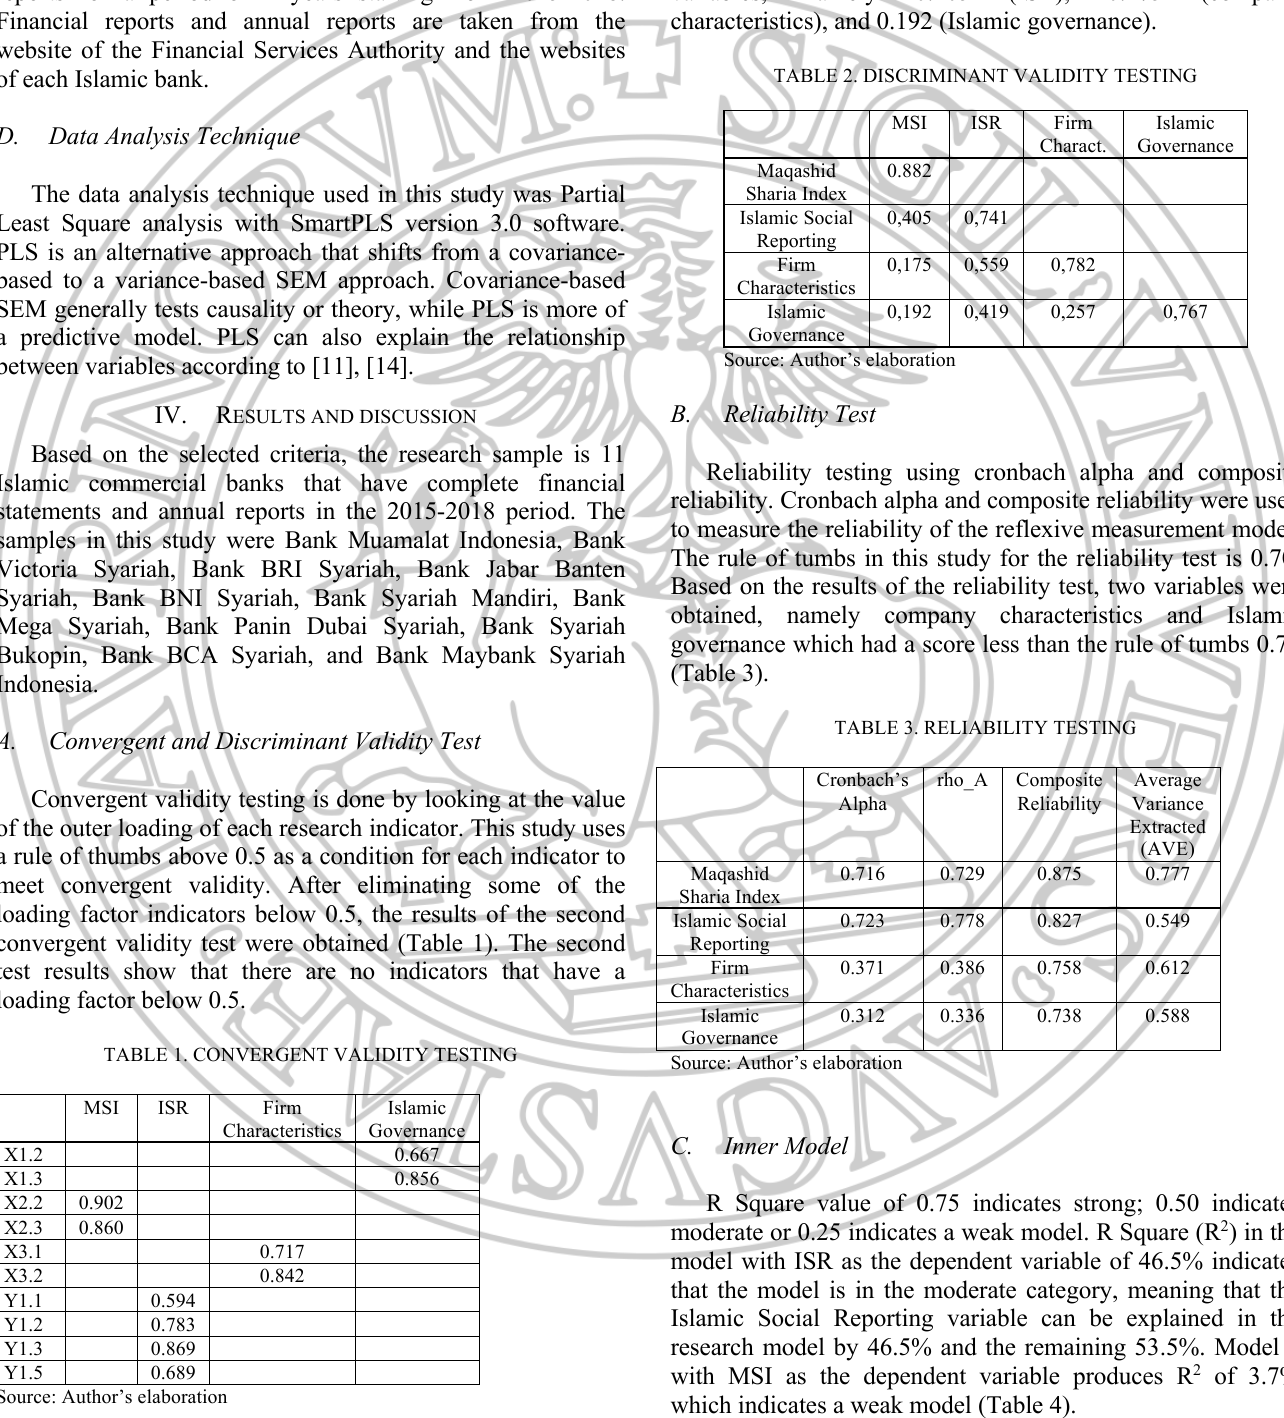
TABLE 2. DISCRIMINANT VALIDITY TESTING